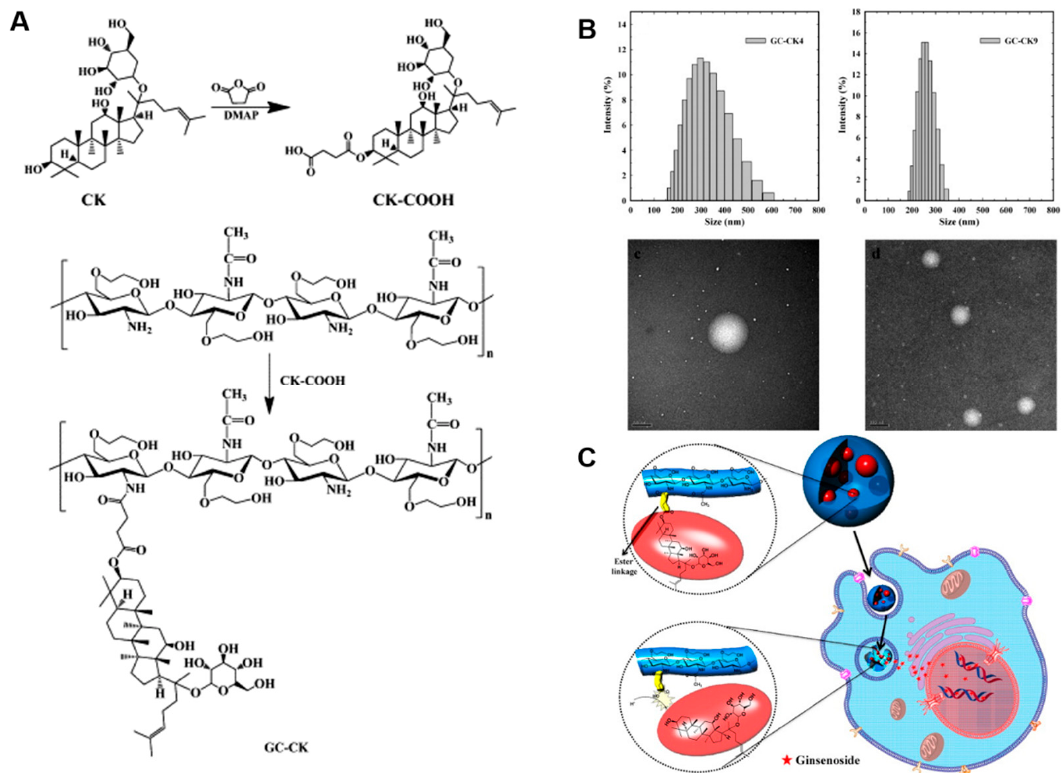
Figure 5. ( A ) Synthesis of compound K-bearing glycol chitosan conjugate. ( B ) Particle size distribu- tion and morphology of compound K-bearing glycol chitosan conjugate with different degrees of substitution of CK to the backbone of glycol chitosan. ( C ) Schematic illustration of pH-responsive release of CK from the conjugate. Reprinted with permission from Ref. [116] . 2014, Elsevier Ltd.